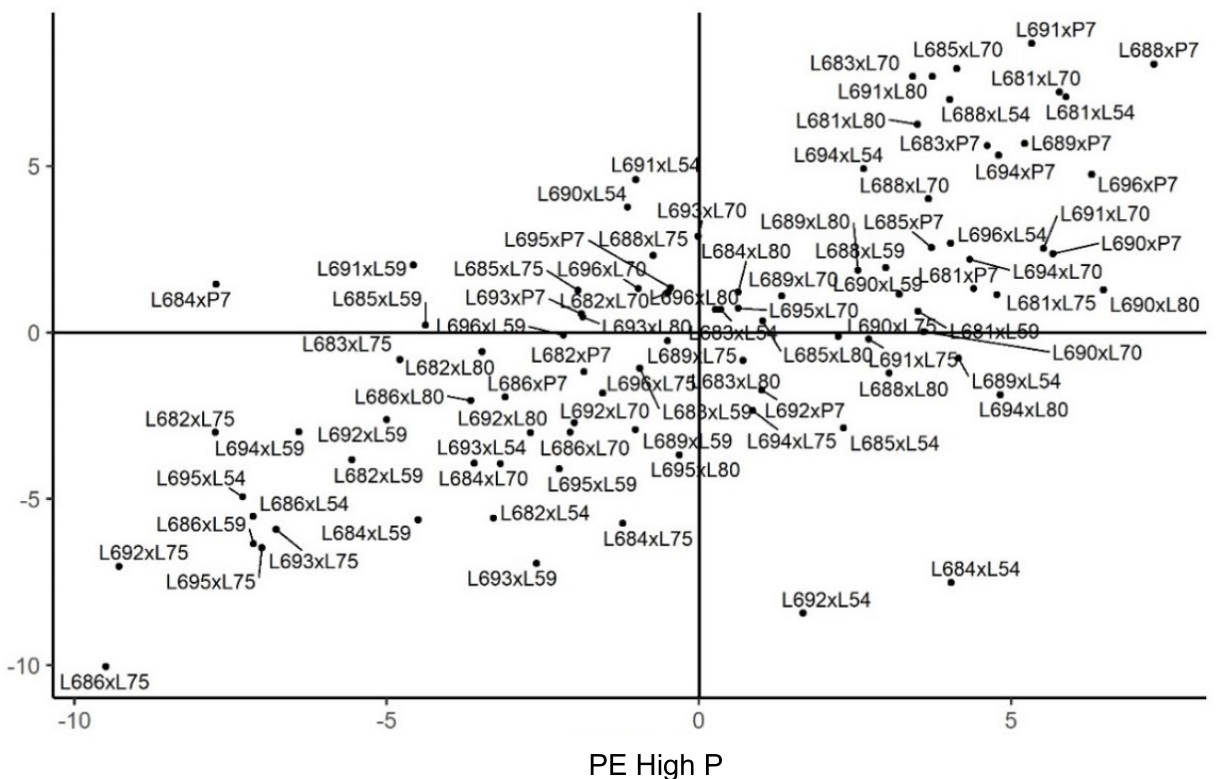
Figure 6. Estimates of the genotypic value (ˆ s ij ) for popping expansion (PE) in diallel hybrids of popcorn evaluated under high and low phosphorus availability in Itaocara. ( − ) signal indicating negative values.